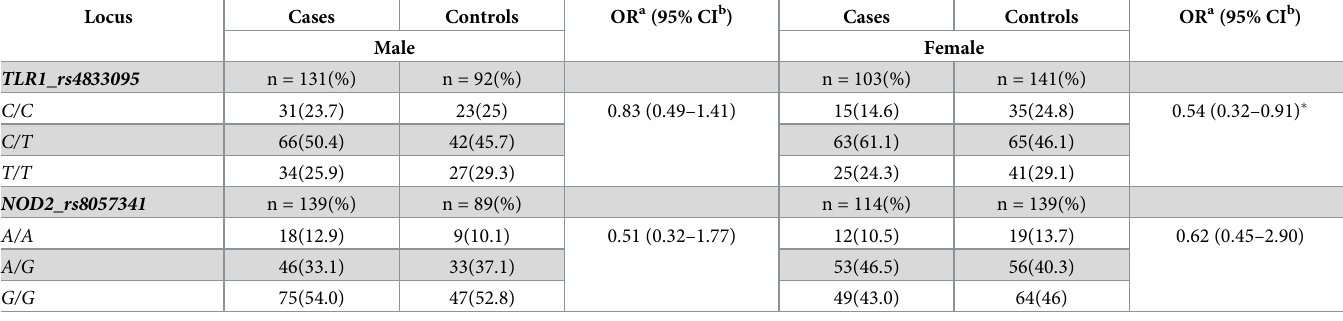
Table 2. Genotypic frequency of rs4833095 and rs8057341 polymorphisms according to sex.